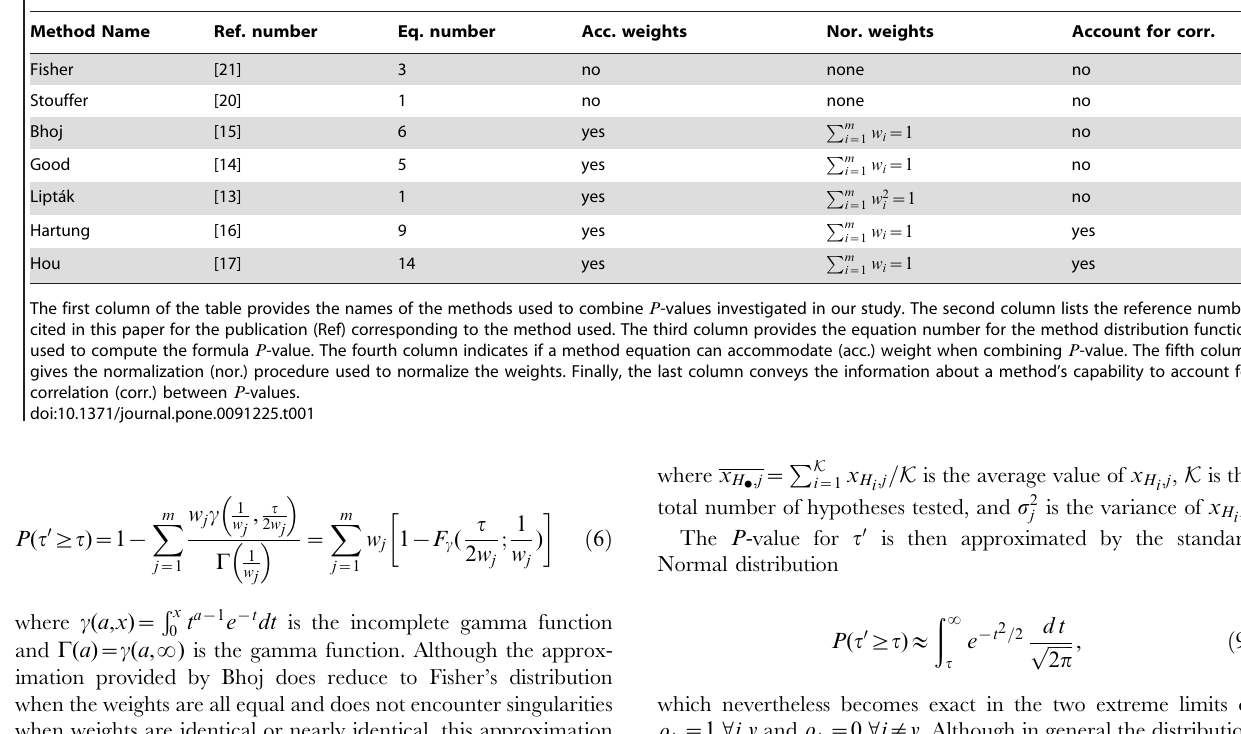
Method Name Ref. number Eq.